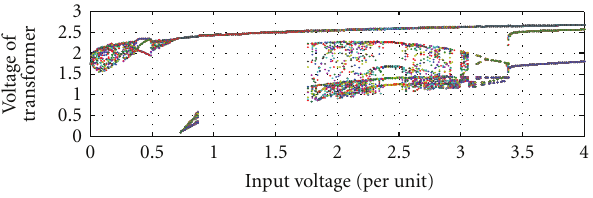
Figure 7: Bifurcation diagram with q = 7 (ZnO e ff ect).